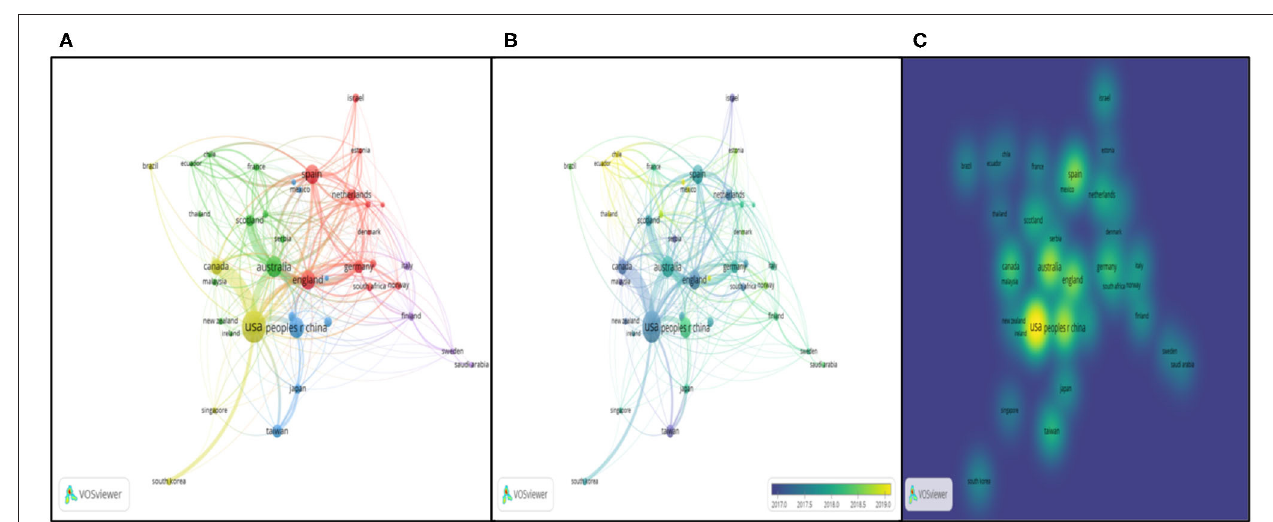
Frontiers in Psychology |